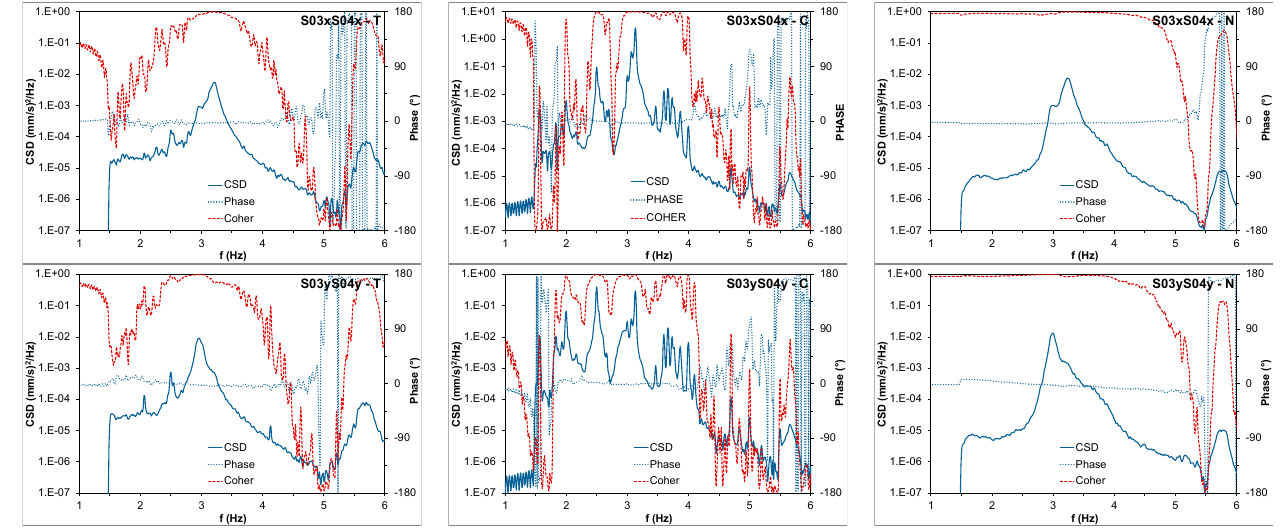
Figure 10. Torre della Moletta: CSDs for the three intervals T, C, and N. It is important to clarify that the vibration effects on the tower are related to the pres- ence and behavior of people, and not to the sound, which involves frequencies out of the range of interest of the structures.